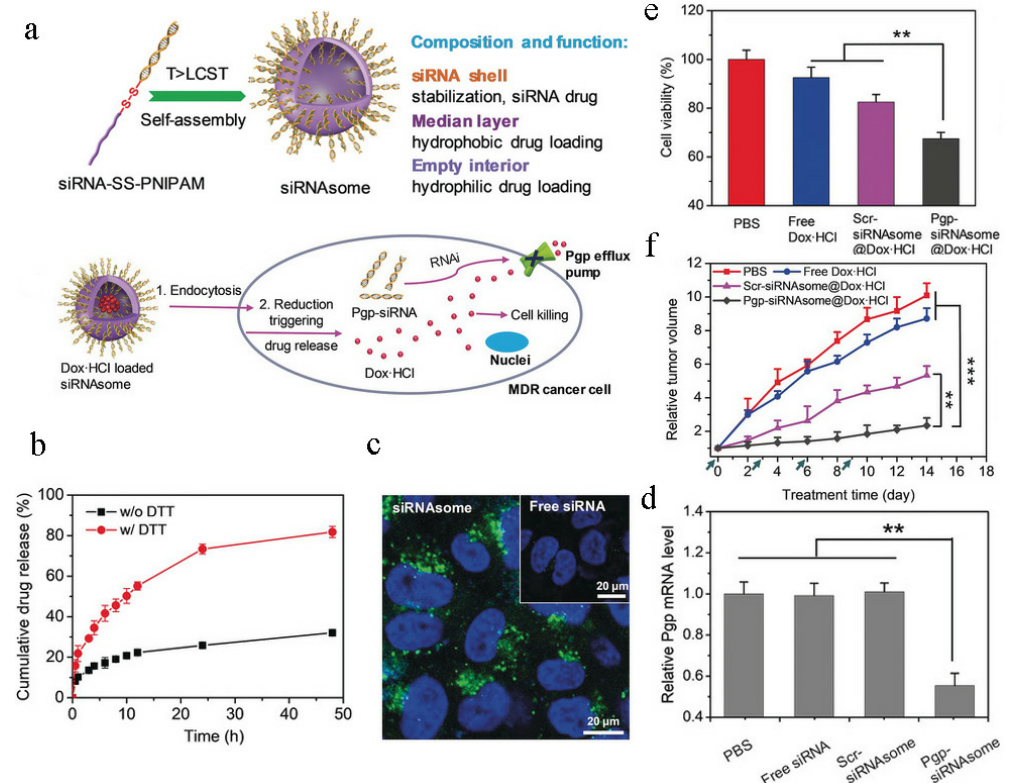
Figure 4. Pgp-siRNAsome@Dox.HCl for synergistic therapy against drug-resistant cancer. Reprinted with permission from Ref. [109]. 2019, Wiley. ( a ) Schematic diagram of the mechanism of Pgp-siRNAsome@Dox.HCl surmounting cancer drug resistance. ( b ) Dox.HCl release from Pgp-siRNAsome@Dox.HCl. ( c ) Cellular uptake of Pgp-siRNAsome@Dox.HCl. ( d ) Gene silencing of Pgp mRNA level in MDR MCF-7 cells. ** p < 0.01. ( e ) In vitro cytotoxicity against MDR MCF-7 cells. ** p < 0.01. ( f ) In vivo antitumor effect of Pgp ‐ siRNAsome@Dox.HCl. ** p < 0.01, *** p < 0.001.